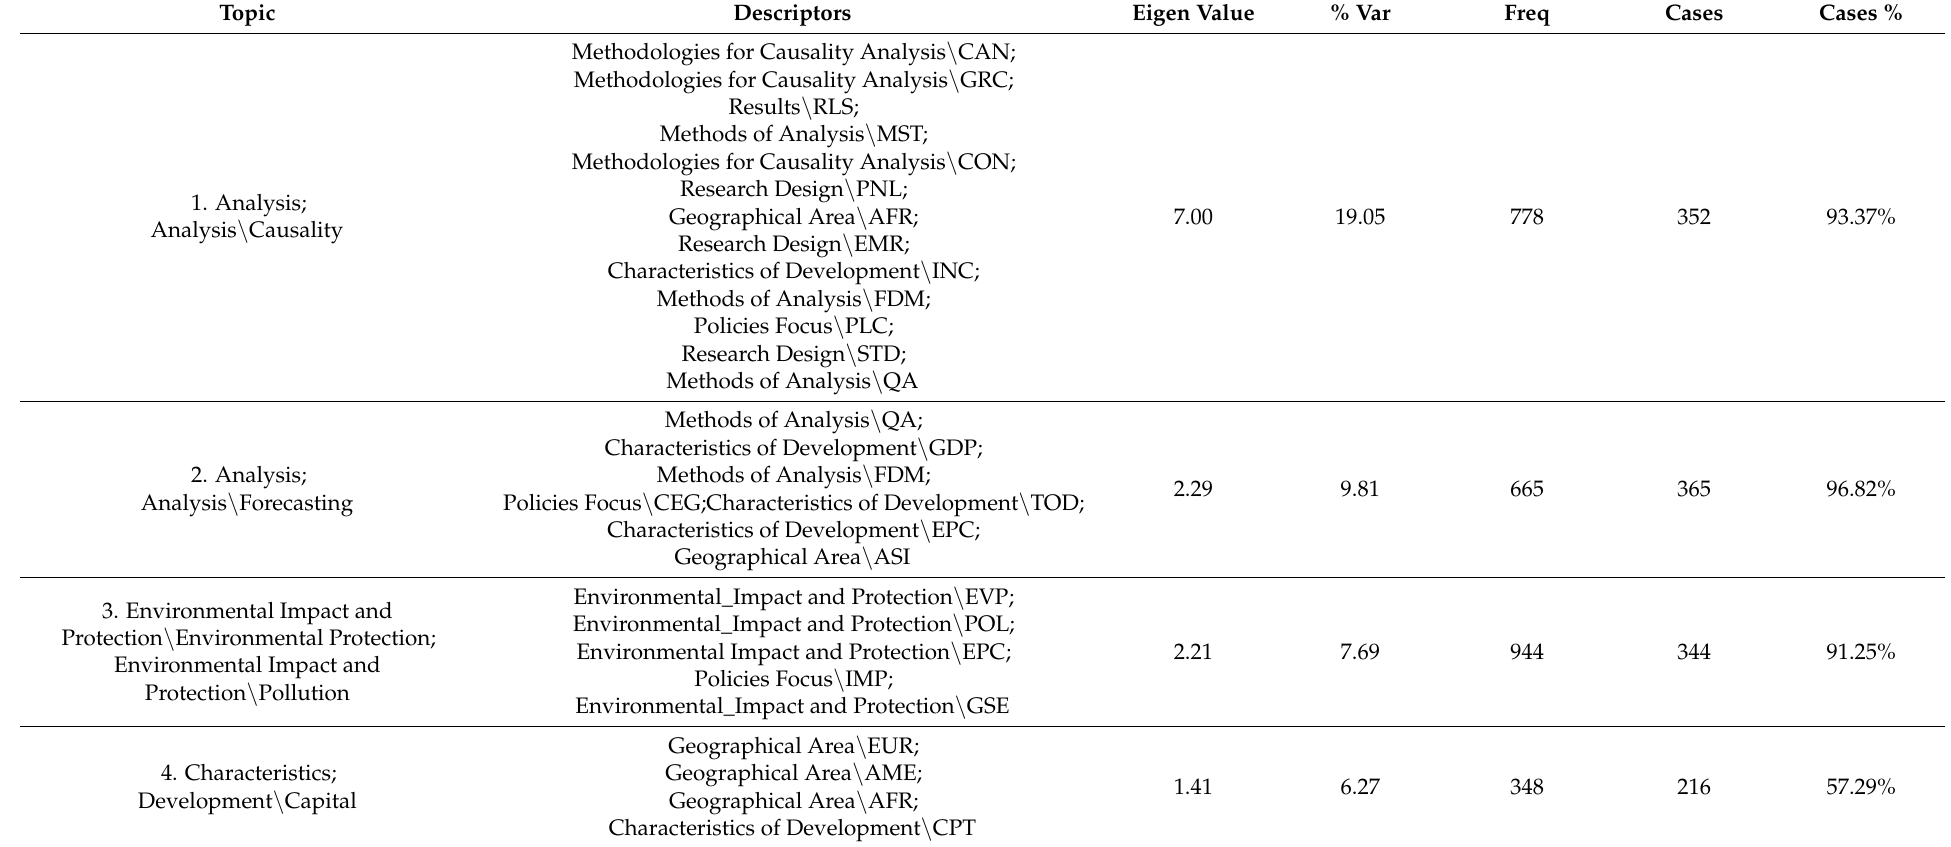
Table 5. Important topics for the period